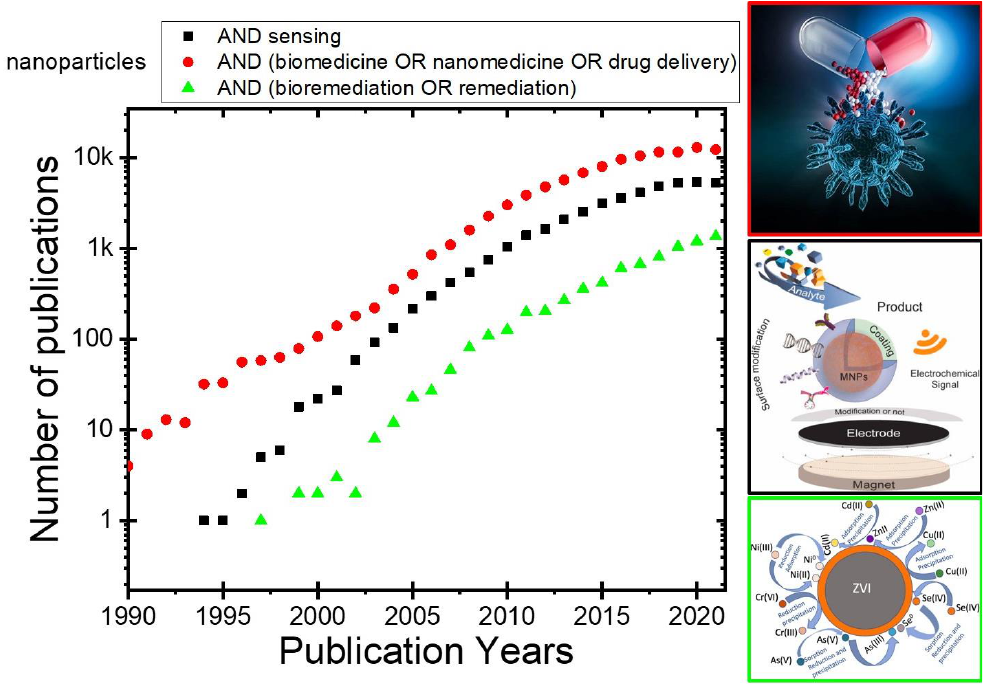
Figure 2. Number of publications with keywords: nanoparticles in combination with ◼ sensing, ⚫ biomedicine or nanomedicine or drug delivery, and ▲ bioremediation or remediation in the last years.